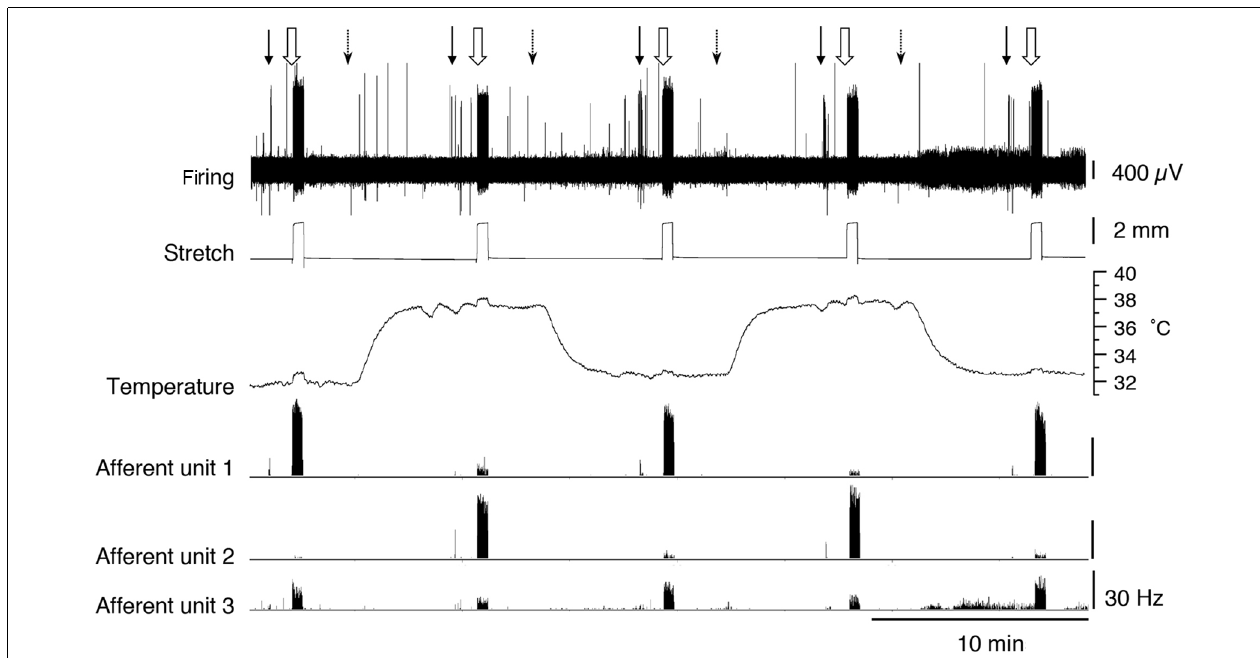
FIGURE 4 | Firing of three muscle afferent units [spontaneous, von Frey hair-evoked (arrows) and stretch-evoked (open arrows)] and effects of temperature (dotted arrows). Three different responses were seen among three units discriminated from the same nerve. Afferent unit 1 had no spontaneous firing and responses to both von Frey hairs and stretch were decreased at 37 ◦ C. Afferent unit 2 also lacked spontaneous firing but showed larger responses to both von Frey hairs and stretch at 37 ◦ C compared to 32.7 ◦ C. Afferent unit 3 had modest spontaneous firing which was reduced at the raised temperature. Unit 3’s responses to von Frey hairs and stretch were both reduced at 37 ◦